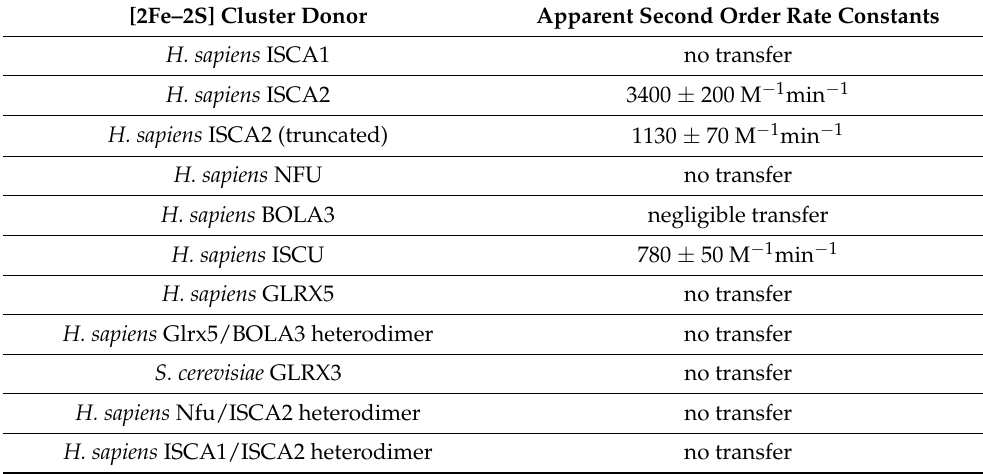
Table 1. Apparent second-order rate constants determined for the transfer of [2Fe–2S] clusters to as- isolated LIAS by various cluster donor proteins (including monomers, and homo- and